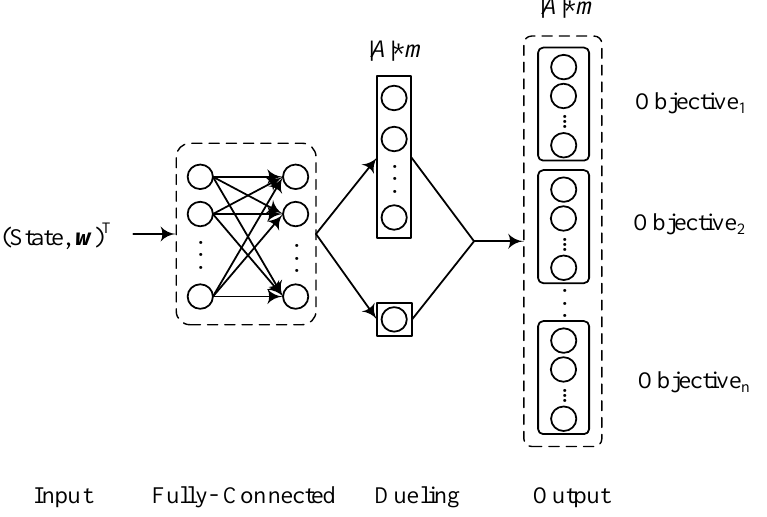
Figure 2. Dueling MODRL framework. First, the agent takes as the input the observed state and preference vector, and then through two fully connected layers, the advantages of each action are fully considered through the dueling structure. Finally, the optimal action is